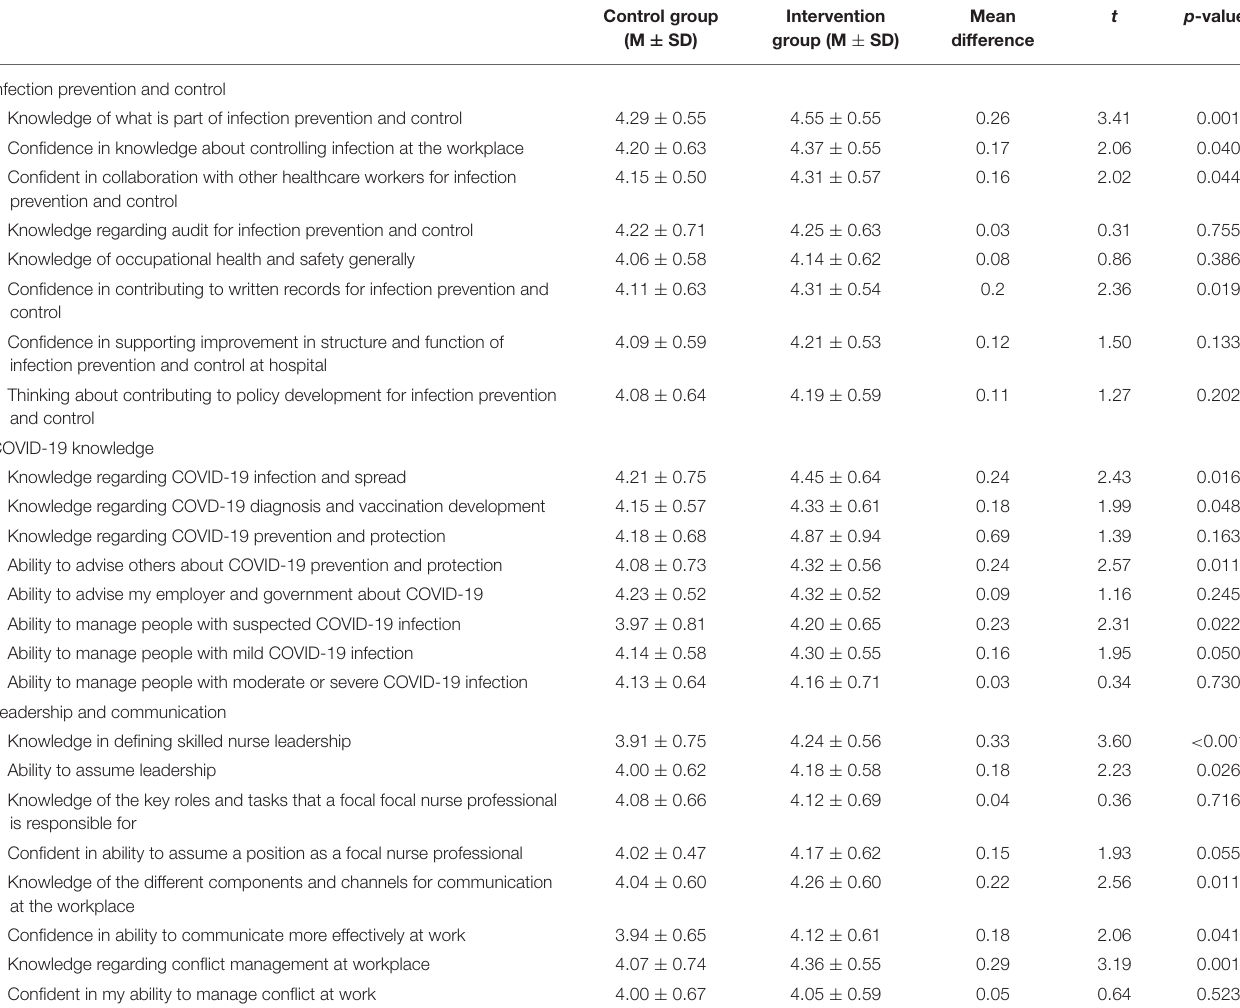
TABLE 4 | Mean results for individual items measuring the intervention area for the control and intervention group at post-intervention ( n =